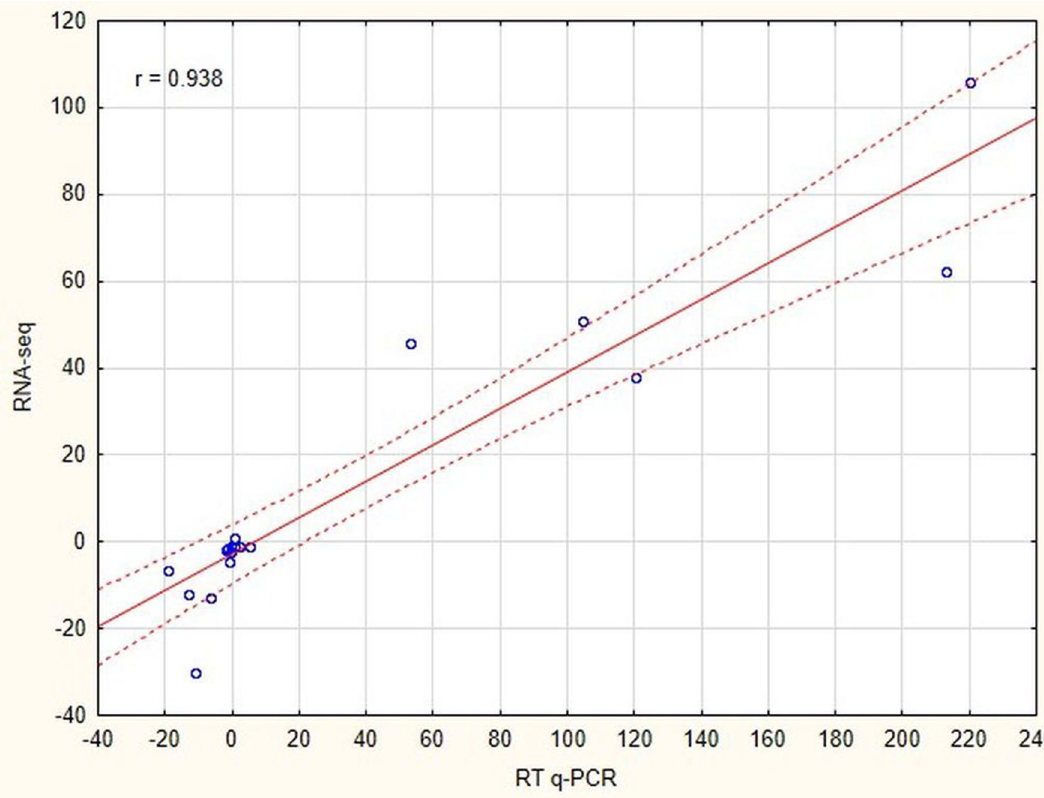
Figure 2. Validation of RNA-seq data using RT-qPCR. Fold changes in gene expression detected by RNA-seq are plotted against the RT-qPCR data. The reference line indicates a linear relationship between the results of RNA-seq and RT-qPCR. r Pearson correlation